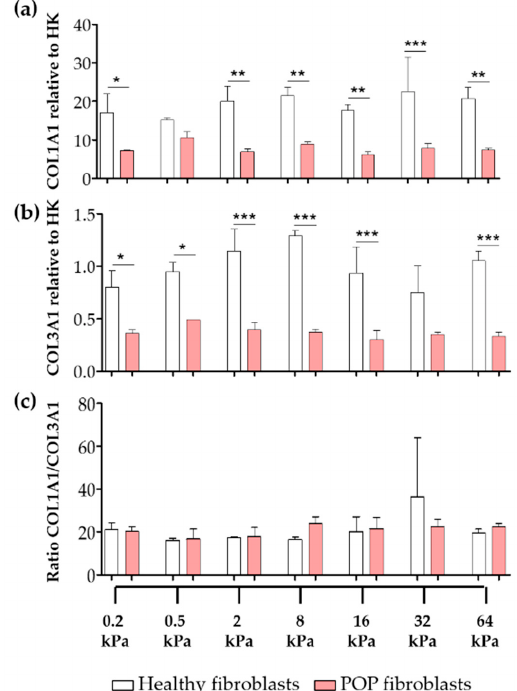
Figure 2. Gene expression of collagens of vaginal fibroblasts on different substrate stiffnesses. Healthy or POP fibroblasts were seeded for 48 h on collagen coated plates with specific stiffnesses: 0.2 kPa, 0.5